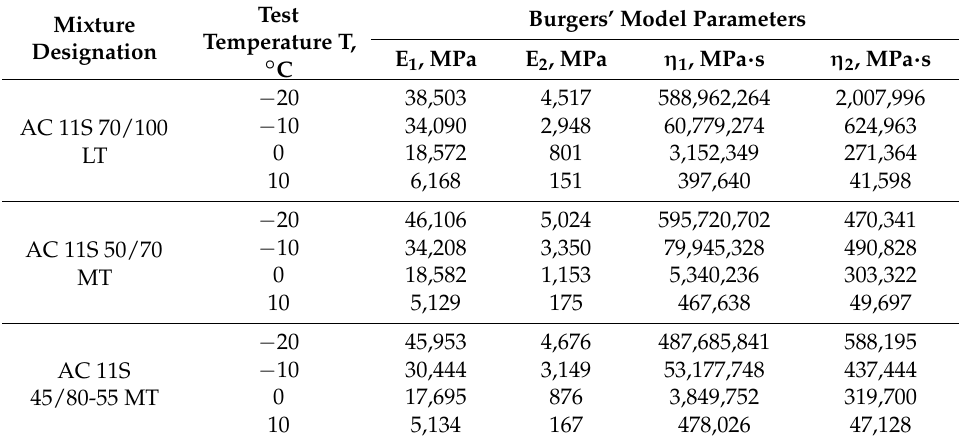
Table 5. Burgers’ model parameters for the Bending Beam Creep Test